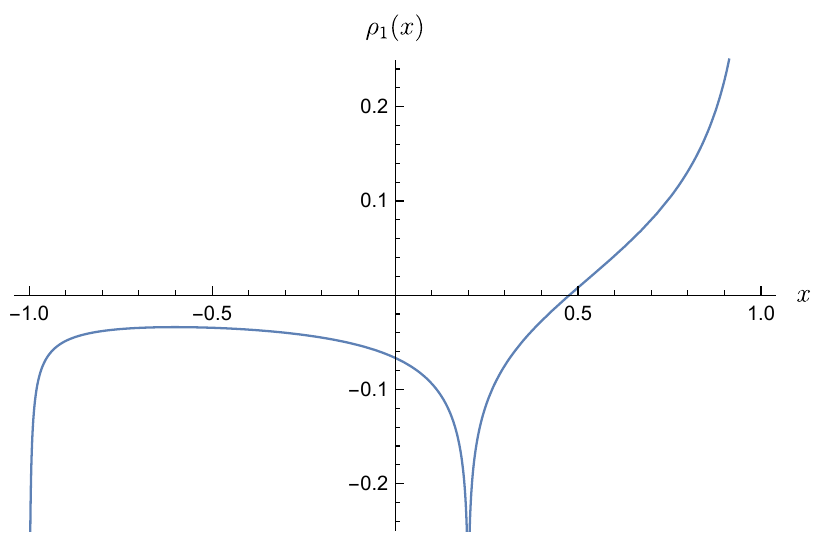
Figure 2 . ρ 1 ( √ λx ), the 1 /N correction to the density, at large λ and with z = 0 . 2. The analytic expression is given by